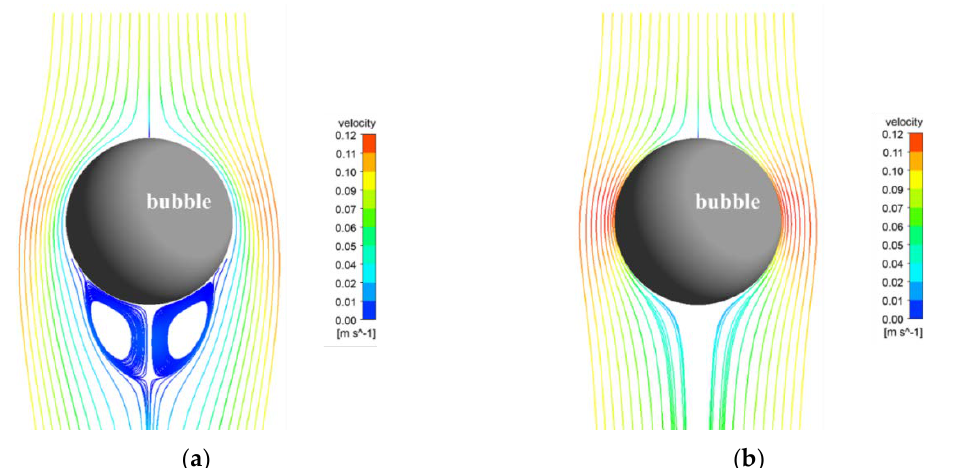
Figure 4. Water streamline at bubble diameter = 0.9 mm ( a ) immobile surface bubble; ( b ) mobile surface bubble.